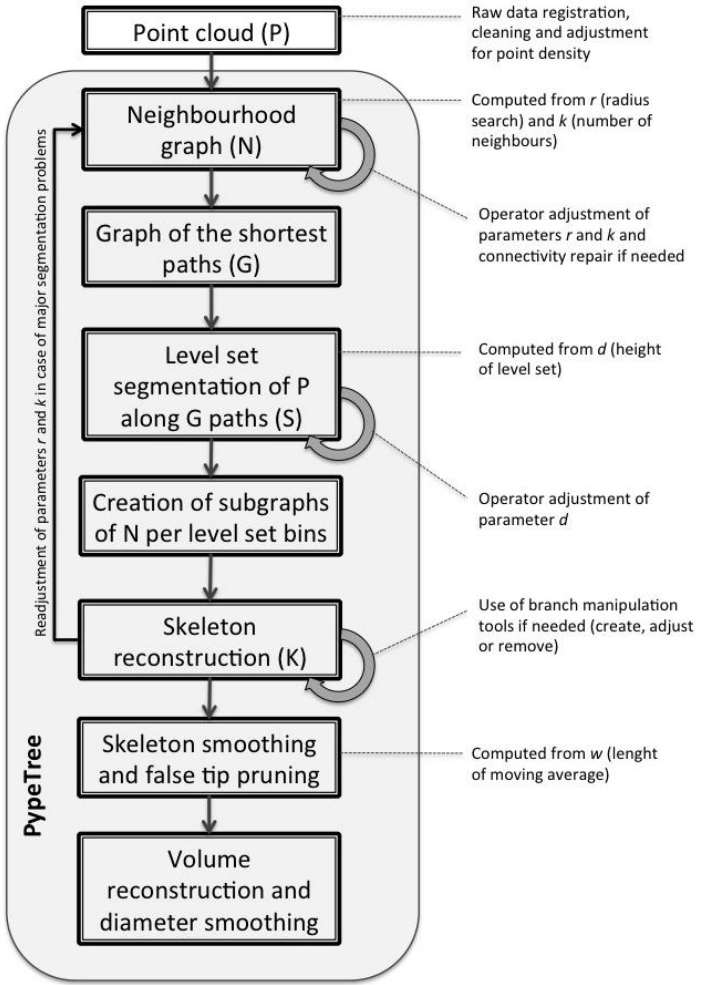
Figure A1. Conceptual diagram of the PypeTree